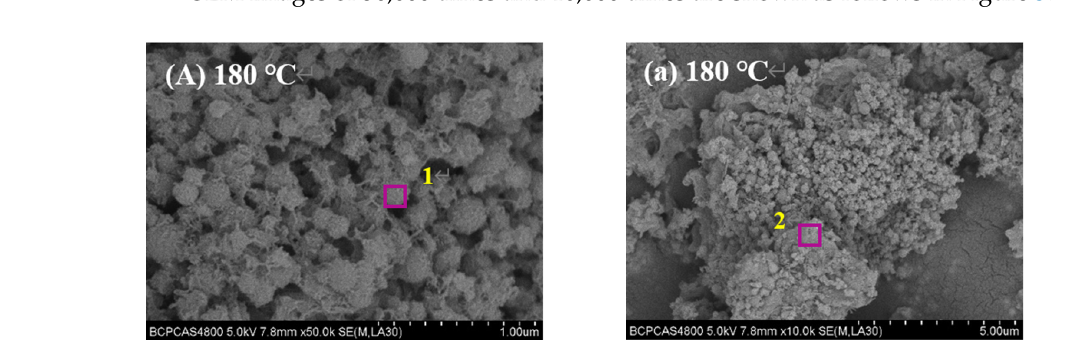
Figure 2. XRD patterns of synthesis products. A—dicalcium silicate ( β -2CaO · SiO 2 ), B—calcite (CaCO 3 ), C—crystalline C–S–H, D—gyrolite (Ca 4 (Si 6 O 15 )(OH) 2 · 3H 2 O), E—tobermorite (5CaO · 6SiO 2 · 5H 2 O), F—calcium silicate hydroxide hydrate (Ca 4.5 Si 6 O 15 (OH) 2 · 3H 2 O). Table 2. Minerals phase information of hydrothermal synthesis of hydrated calcium silicate.